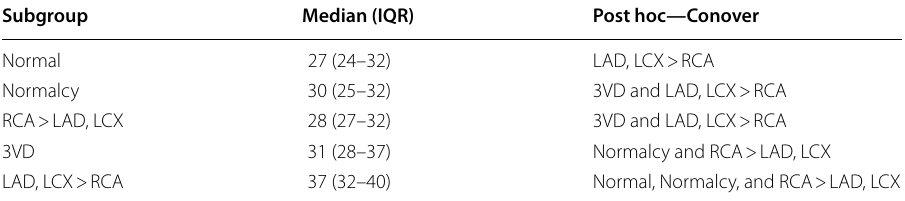
Table 5 Quantitative values of the maximal RV/LV uptake ratio in different subgroups of SPECT/ Angio and normalcy datasets